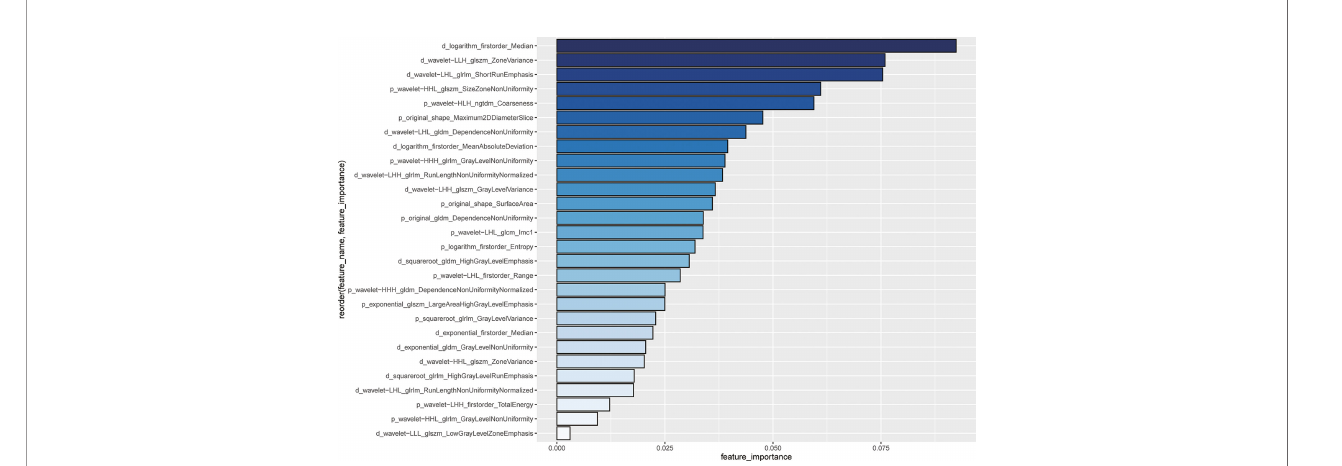
FIGURE 2 | Importance ranking for 28 selected radiomics features using random forest The length of the bin and the depth of the color blue represent the important degree of the radiomics features. The feature name is ordered by the following rule: phase (p or d represents the venous-portal phase or the delayed phase) _ pre- processing_feature category_feature name. For example, for the fi rst feature, i.e., d_logarithm_ fi rstorder_Median indicates that the feature is named as Median from the fi rst-order category, with transformation by